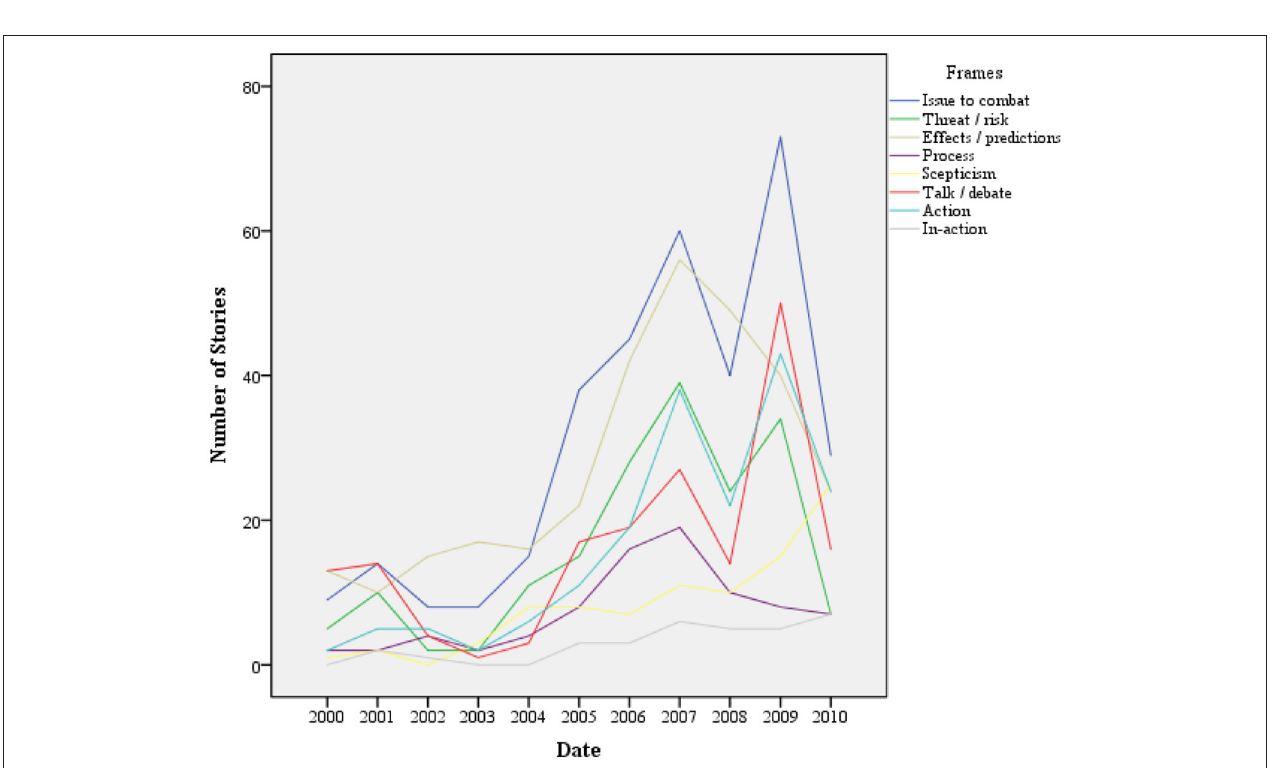
FIGURE 3 | Number of stories by